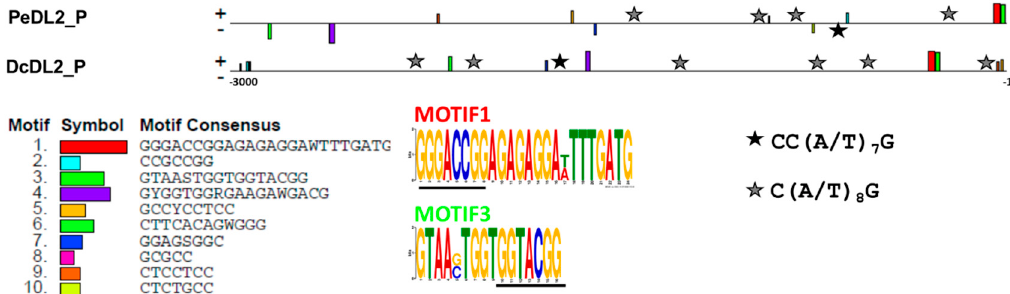
Figure 9. Conserved motifs within the putative promoters of the DL2 genes of P. equestris and D. catenatum . PeDL2_P and DcDL2_P are the nucleotide sequences spanning 3000 bp upstream of the ATG translation start site, numbered from − 1 to − 3000. In the sequence logo of Motifs 1 and 3, the predicted binding site of the TCP factor (JASPAR IDs MA1096.1 and MA1035.1) and of the SBP-type zinc finger (JASPAR ID MA0955.1) are underlined. The black and gray stars indicate the CArG-box variants CC(A/T) 7 G and C(A/T) 8 G, respectively.